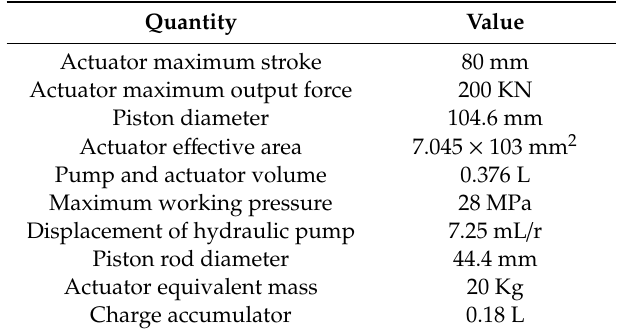
Table 1. Parameters of EHA hydraulic components.